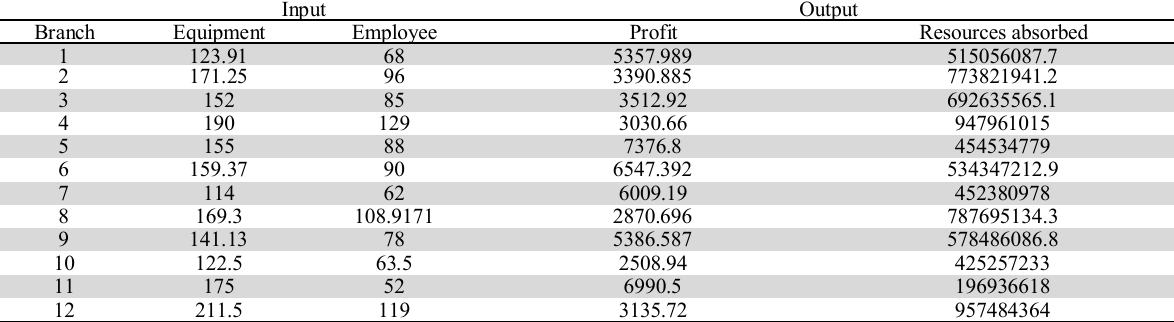
The summary of efficient amount of